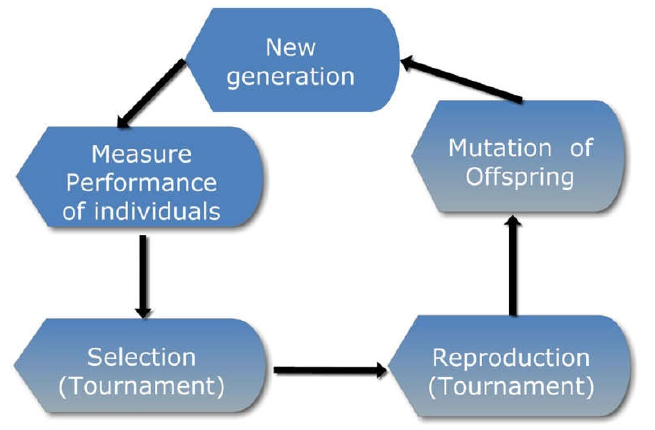
Figure 3. Workflow of genetic algorithm.